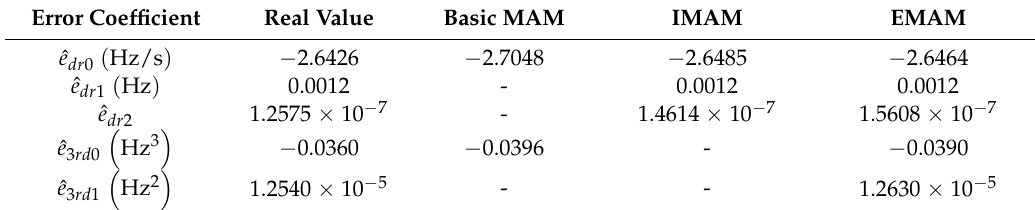
Table 5. The estimation results of the errors of the Doppler parameters by the different methods. Error